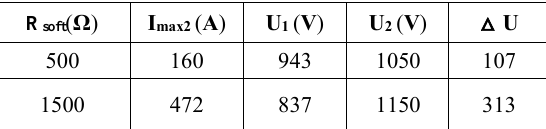
Table 3. The Influence of soft-start resistor on charge voltage and